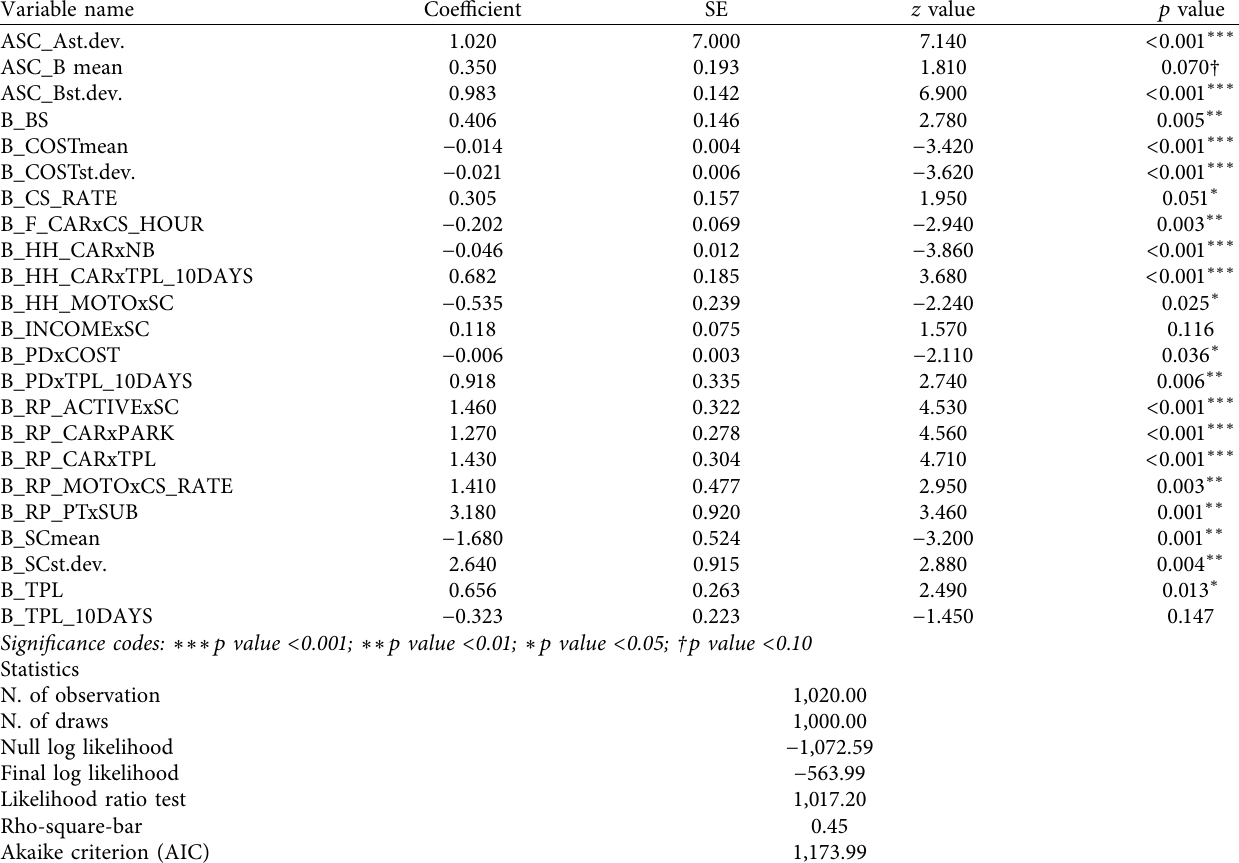
Table 6: MaaS bundle choice-estimated parameters and model